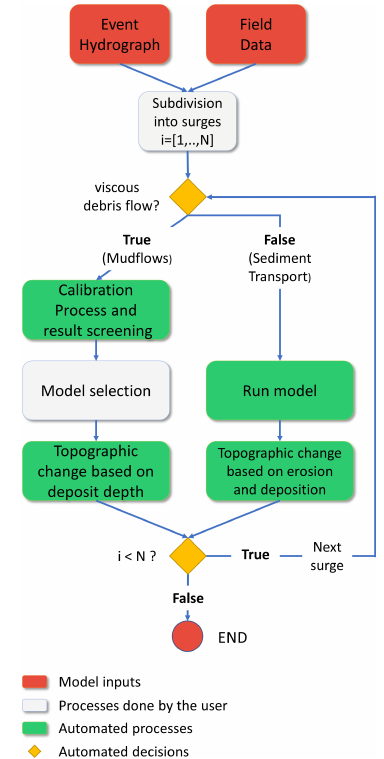
Figure 4. Surge modeling workflow. The main challenge is to find a correlation between surges and field data that allows the user to discriminate between viscous and inertial debris flow surges. The developed routine is able to concatenate the surges by updating the model inputs for the next surge, based on the results of the previous